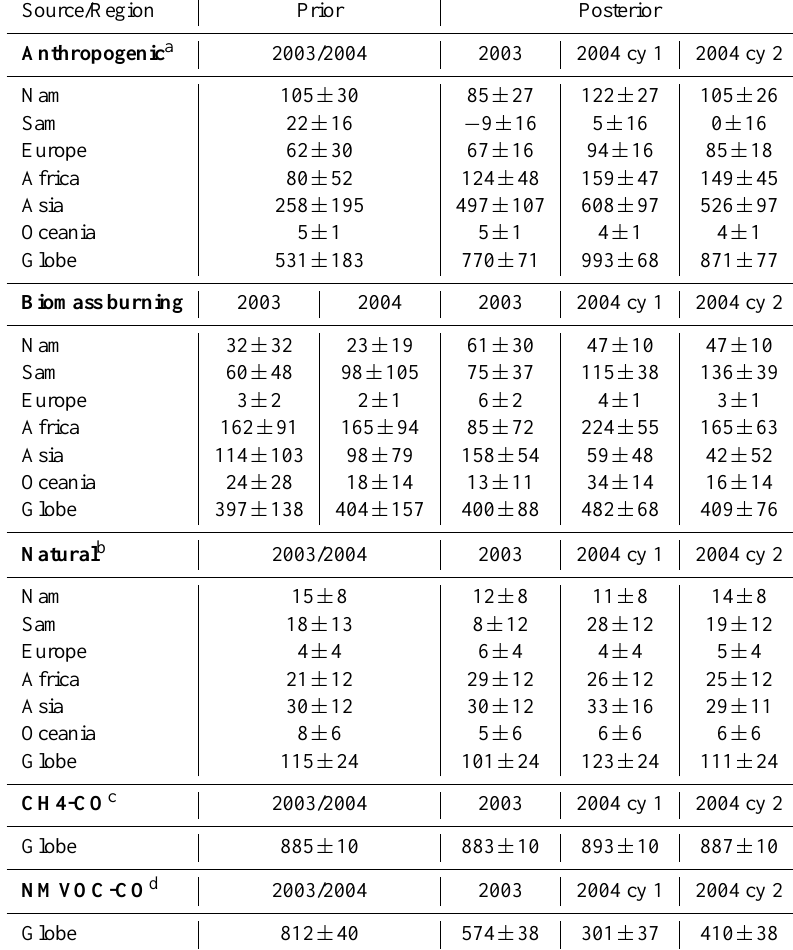
Table 2. Emissions for 2003 and 2004 per continent for three surface source categories (Anthropogenic, Biomass burning and Natural) and two global chemical production terms (methane and NMVOCs). Per source category, the second and third columns specify the prior emission estimates used, the three right-most columns give the posterior emission estimates for the year 2003 (cycle 2) and 2004 (cycle 1 and cycle 2, respectively). The emissions are given in TgCOyr − 1 . Note that the sources of CO production from methane and NMVOC oxidation are given as global totals only, since only a global scaling factor is adjusted. Also, only the biomass burning emission inventory (GFED2) gives year-to-year emissions, the other sources are for the years specified in the